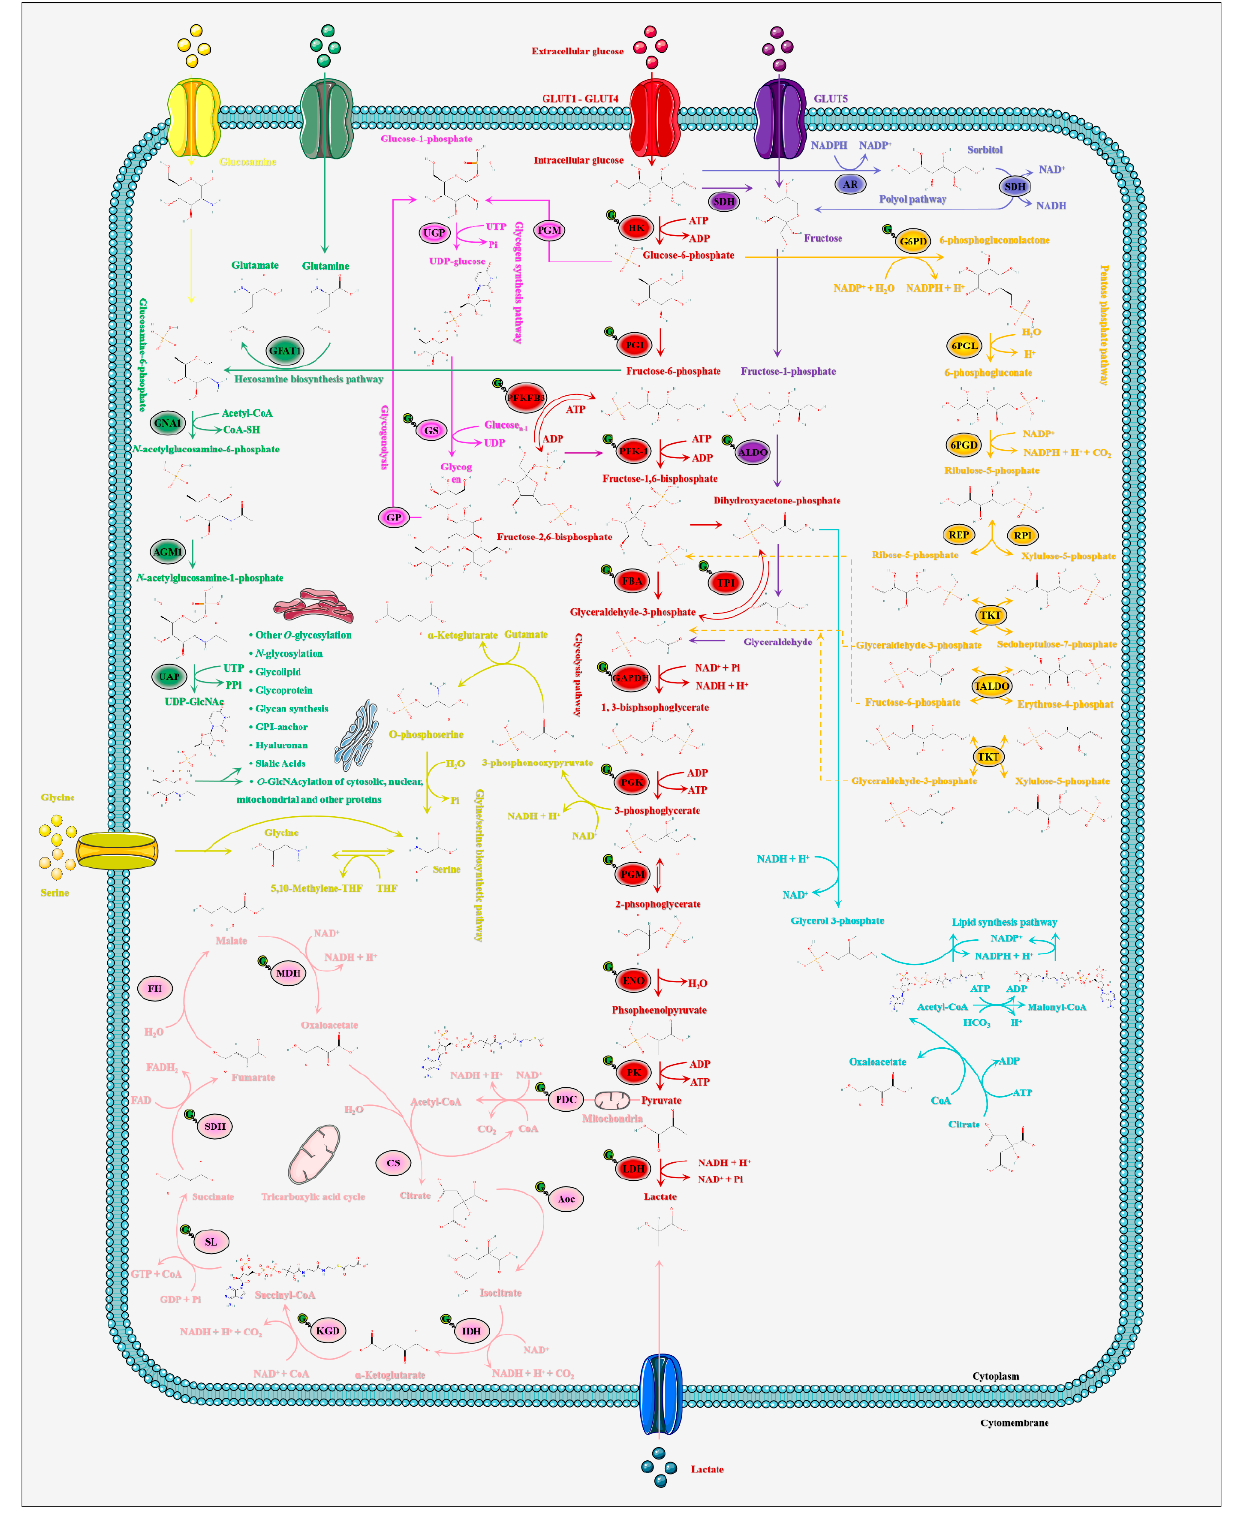
Figure 2. O -GlcNAcylation is linked by the HBP to nutrient availability and thus its regulation of the complex metabolic network. Two percent to 3% of intracellular glucose enters the HBP and undergoes a series of chemical reactions to produce the end product UDP-GlcNAc. The UDP-GlcNAc in the nucleus, cytoplasm and membrane is utilized for O -GlcNAcylation. UDP-GlcNAc makes the dynamic O -GlcNAcylation extremely sensitive to changes in cellular nutrients used as a sensor of the functional state of multiple pathways such as glycolysis, TCA cycle, pentose phosphate pathway (PPP), glycogen synthesis and catabolism, etc. Meanwhile, the interconversion of intermediates between the HBP, polyol pathway, fructose, PPP, glycogen, glycolysis and TCA cycle greatly enhanced the nutritional sensitivity of O -GlcNAcylation. A portion of UDP-GlcNAc is transported to the endoplasmic reticulum and the Golgi apparatus while being used for other O - glycosylation and N -glycosylation. Other fractions of UDP-GlcNAc are used for the biosynthesis of proteoglycans, hyaluronic acid, glycolipids, glycolphosphatidylinositol anchoring, etc.